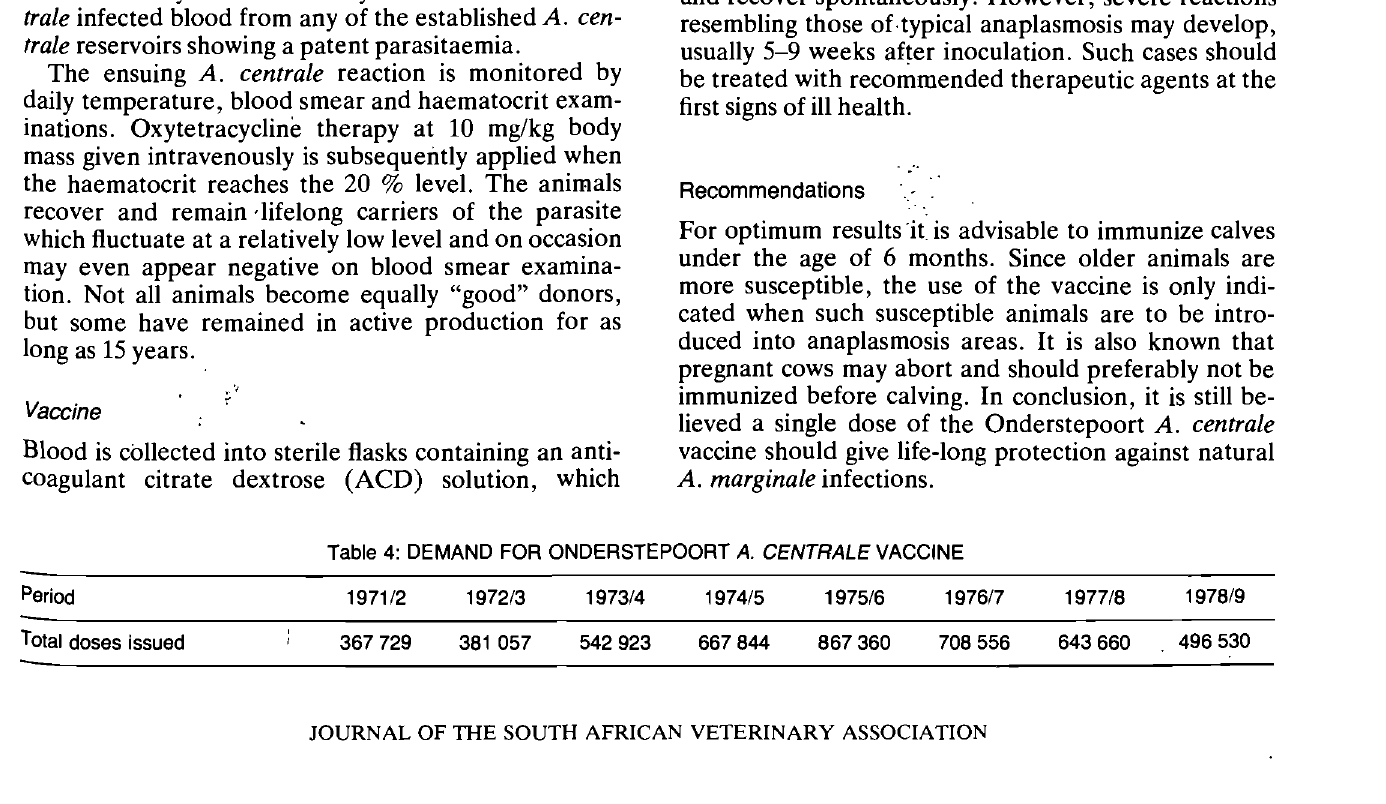
Table 4: DEMAND FOR ONDERSTEPOORT A CENTRALE